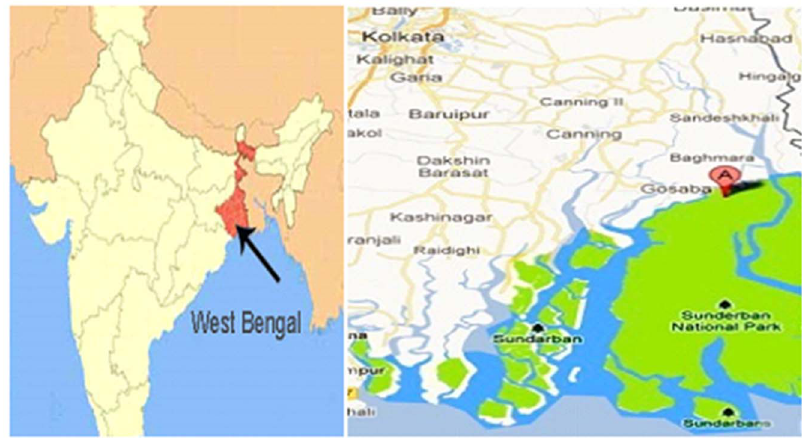
Figure 1. Study site: A mark on map (not on scale) depict the actual local of the study area, Sundarbans, West Bengal, India.